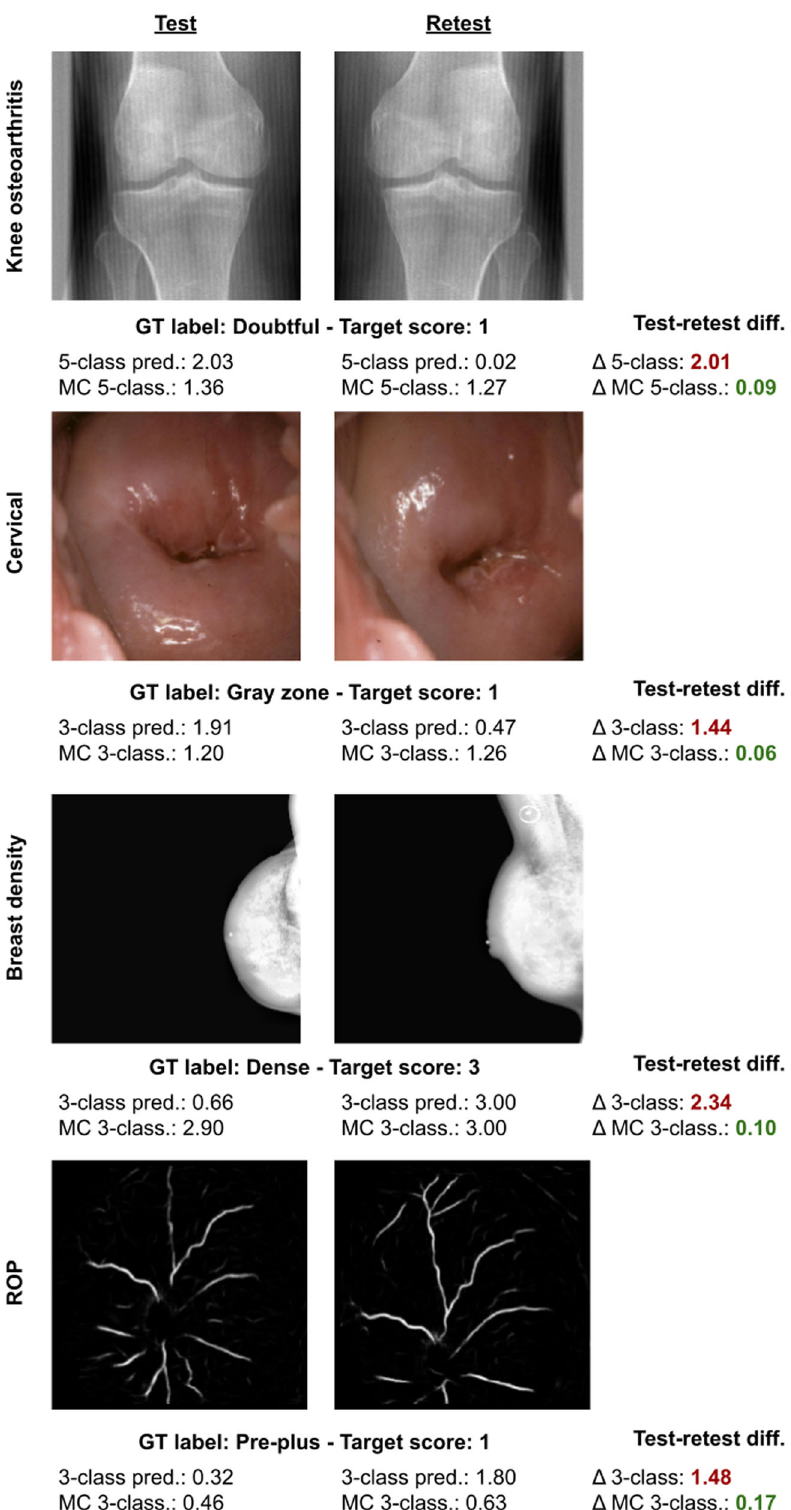
Fig. 3 Repeatability comparison for multi-class vs. MC multi-class models for each dataset. These cases illustrate extreme cases where multi-class predictions failed to be repeatable while MC multi-class performed decently. These examples were picked choosing images where the repeatability difference between the continuous scores was the largest between multi-class and MC